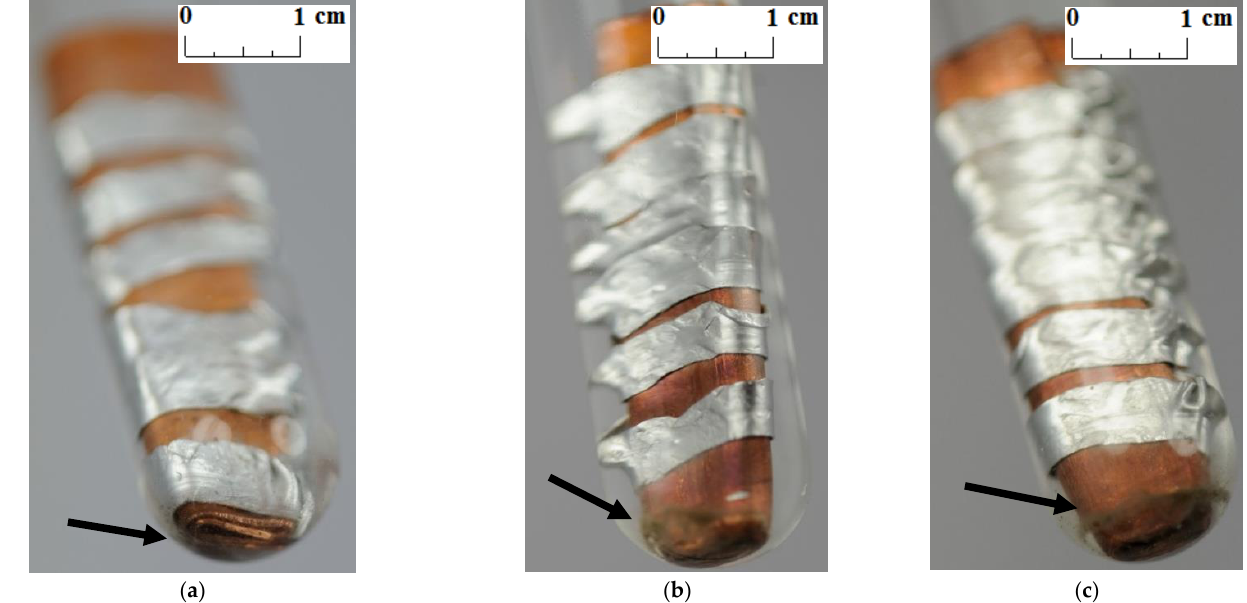
Figure 5. The precipitate which deposited on the sample with a combination of aluminum and copper immersed in RT15; ( a ) after 3 weeks; ( b ) after 4 weeks; and ( c ) after 7 weeks.